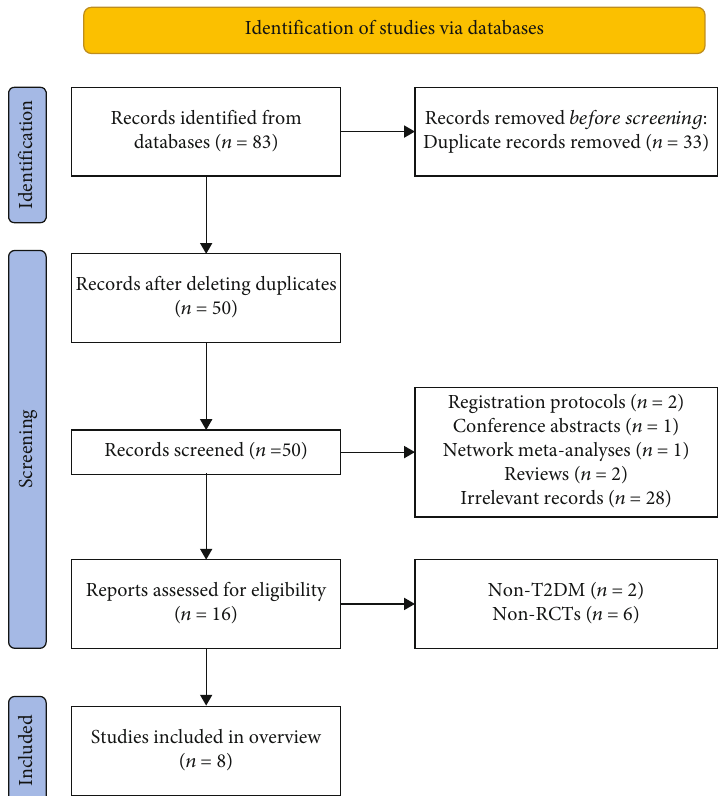
Figure 1: The fl owchart of the screening